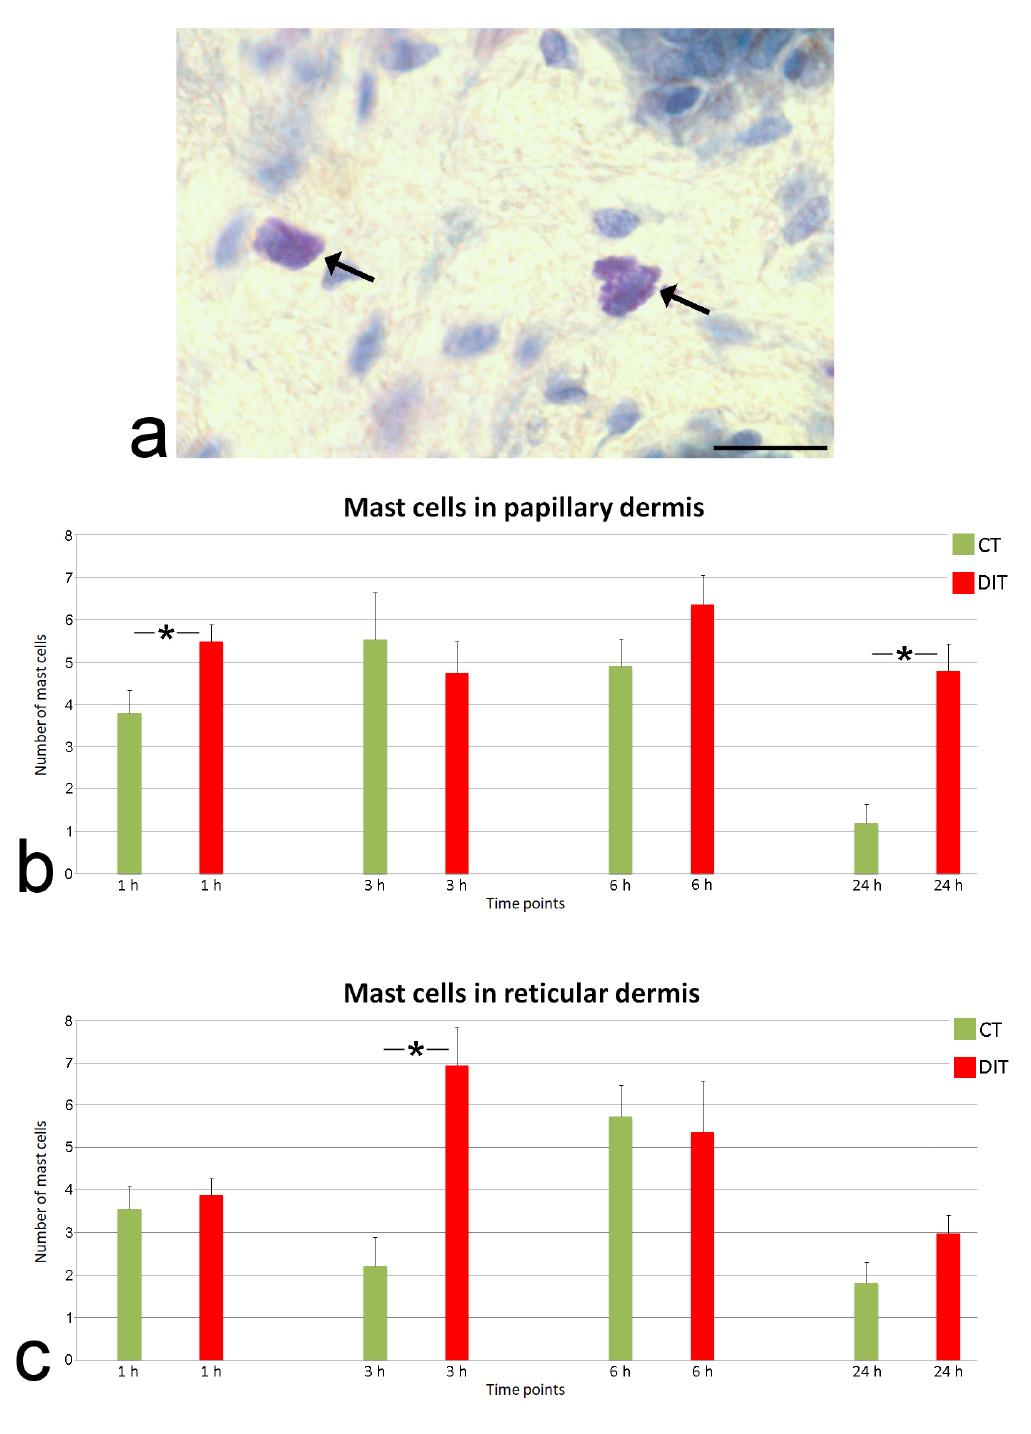
Figure 5. ( a ) Mast cells stained with the acidified toluidine blue method (arrows); note the red-violet granules. Bar: 20 µm. ( b , c ) Mean ± standard error values of mast cell number in papillary ( b ) and reticular ( c ) dermis. Asterisks indicate signi fi cant di ff erence. In papillary dermis: 1 h CT vs. 1 h DIT, p = 0.028; 24 h CT vs. 24 h DIT, p = 0.001). In reticular dermis: 3 h CT vs. 3 h DIT, p < 0.001. CT, control (untreated); DIT, dithranol-treated.